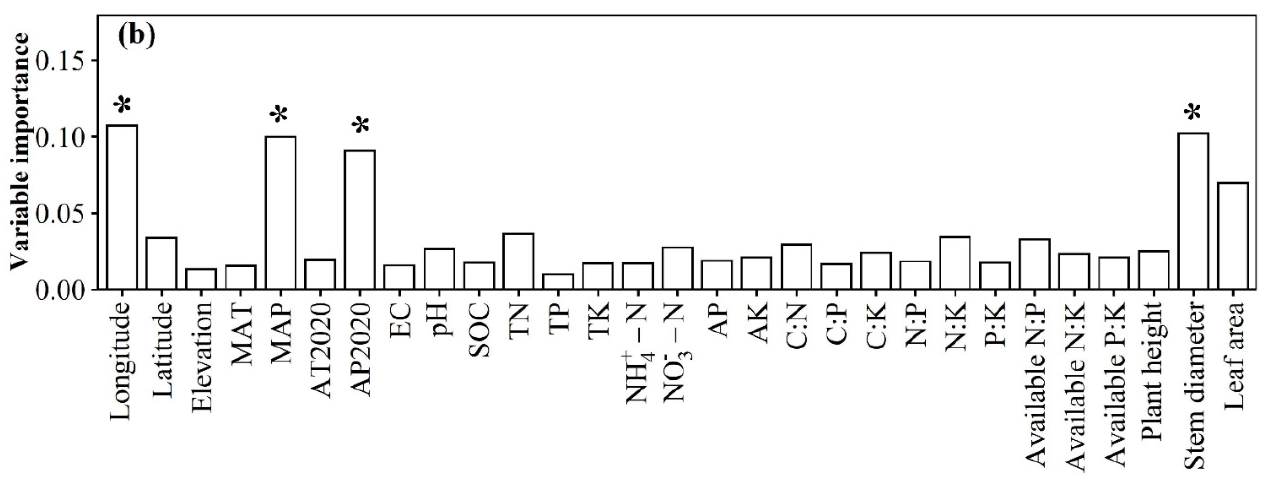
Figure 1. Relative impacts of environmental variables on total abundance of soil fungal community for ( a ) topsoil and ( b ) subtopsoil. The * above the bar indicated this variable had a significant influence on total abundance of soil fungal community at p < 0.05 level. MAT: mean annual temperature in